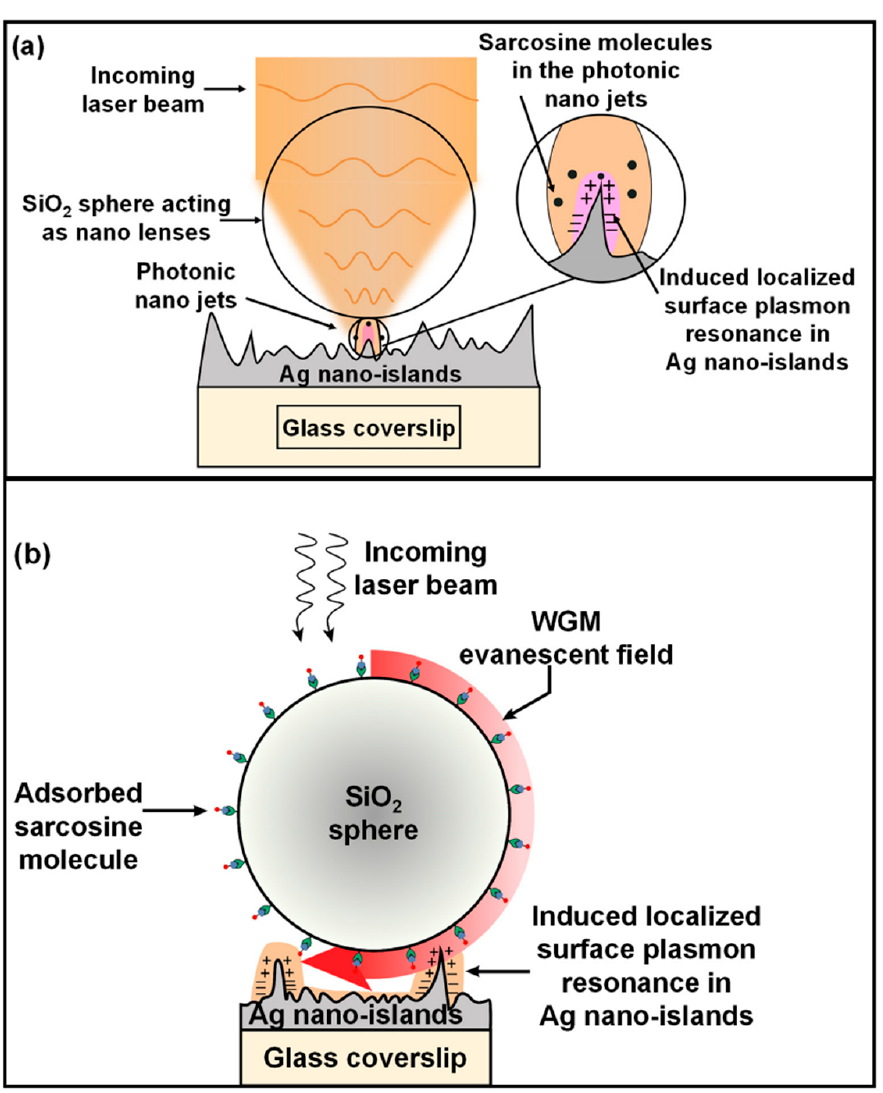
Figure 6. ( a ) The incoming laser beam becomes focused by the SiO 2 microspheres creating a high- intensity subwavelength width photonic nano-jet that scans the sarcosine molecules inside it. Photonic nano-jets induce LSPR in Ag nano-islands to further increase the local field intensity which further enhances the SERS signal; ( b ) the resonant WGM waves propagate close to the SiO 2 sphere surface, scanning the sarcosine molecules adsorbed in it. It further induces LSPR into the Ag nano-islands, increasing the local field which causes SERS